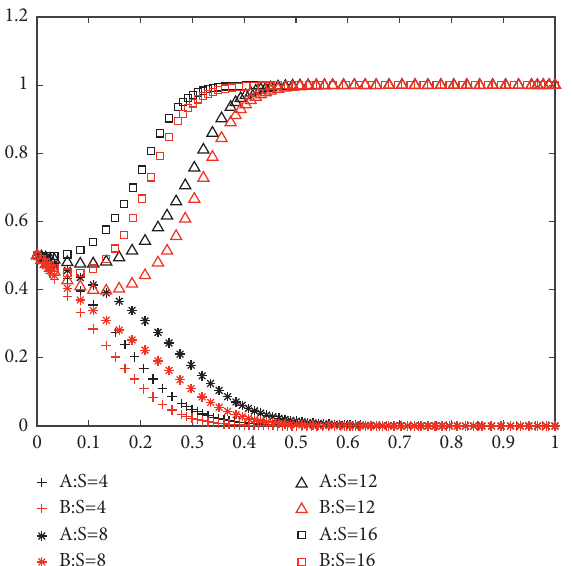
Figure 5: Evolutionary analysis of the change in the reduction of cooperation costs of SMEs with the participation of fintech